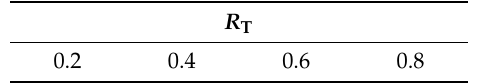
Table 2. Cross-section reductions in extrusions with single-pass dies ( R T ).